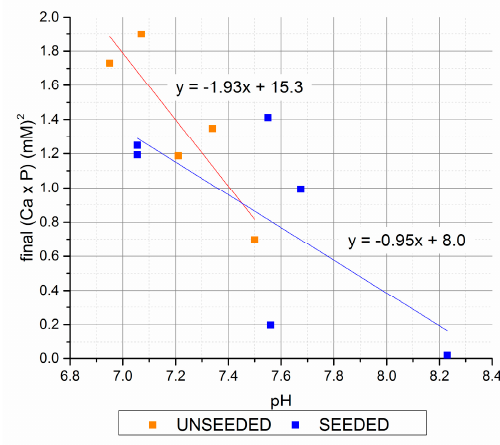
Figure 5. Final (Ca × P) versus final pH (seeded and unseeded).